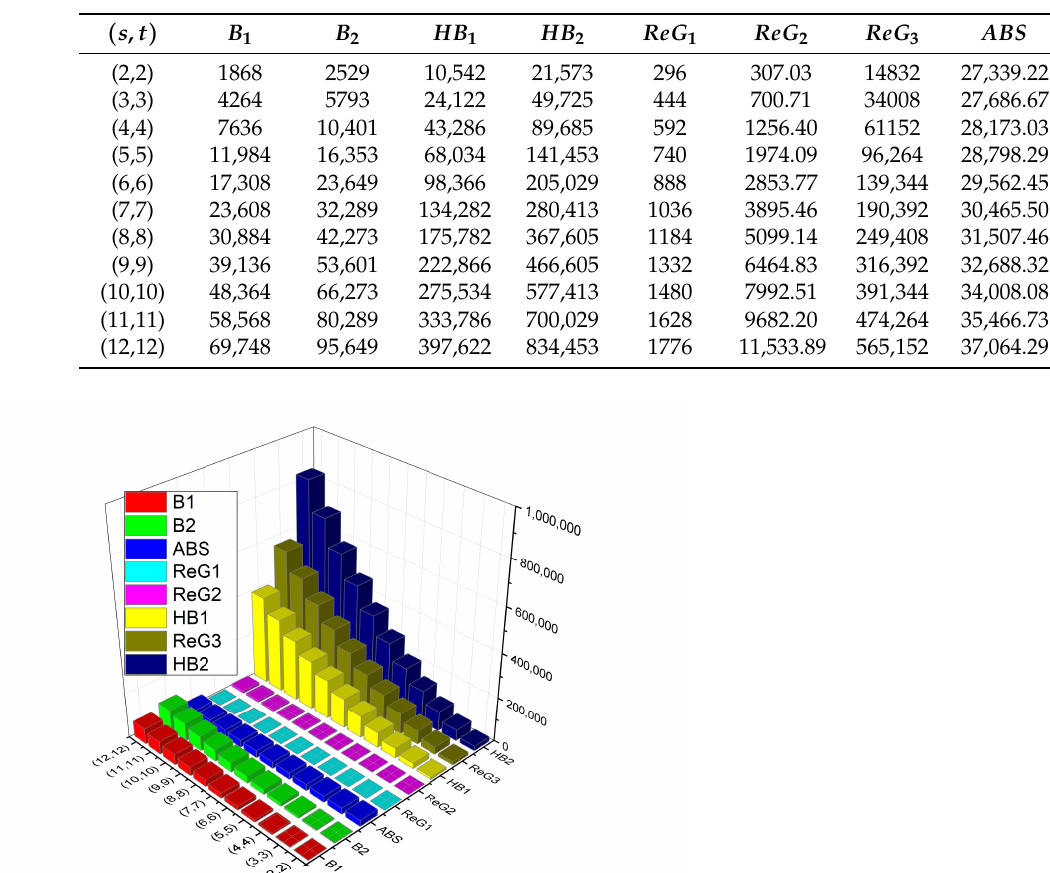
Table 4. Numerical comparison of the topological indices of MOF ( s,t ) .